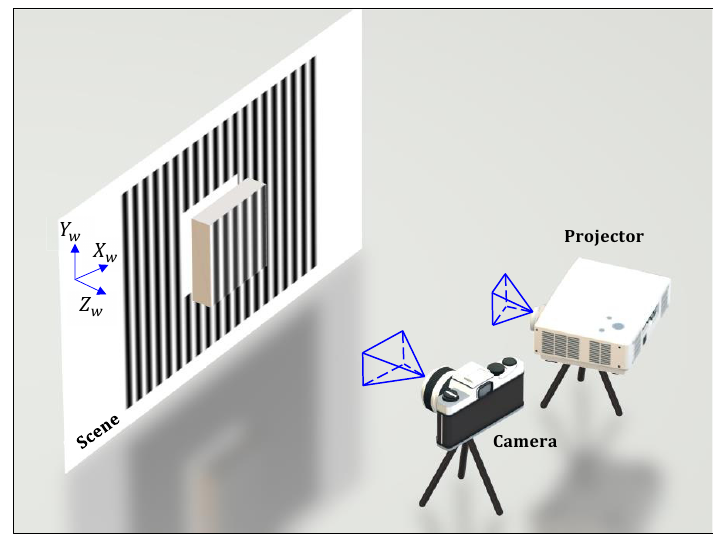
Figure 1. Schematic of the FPP-based 3D imaging and shape measurement